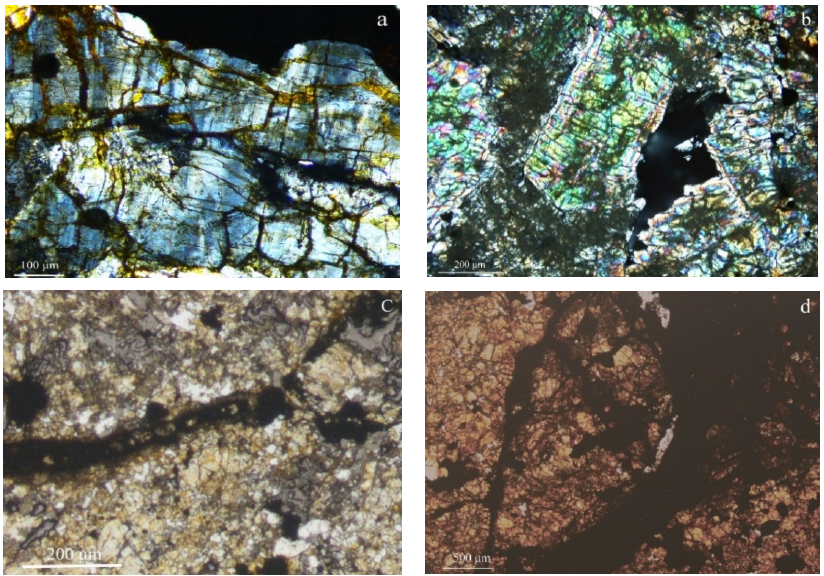
Figure 5. ( a ) Photomicrograph of olivine in GRV 020069 (S2) under cross-polarized light. The grey-colored grain in the center of the view exhibits undulatory extinction. ( b ) Photomicrograph of olivine in GRV 022244 (S3) under cross-polarized light. The grain of olivine has two sets of planar fractures. ( c ) Photomicrograph of shock-induced vein in GRV 020125(S4) under plane-polarized light. Some silicate clasts can be found in vein. ( d ) Photomicrograph of shock-induced vein in GRV 022194(S5) under plane-polarized light. Melt pockets and shock veins are pervasive.